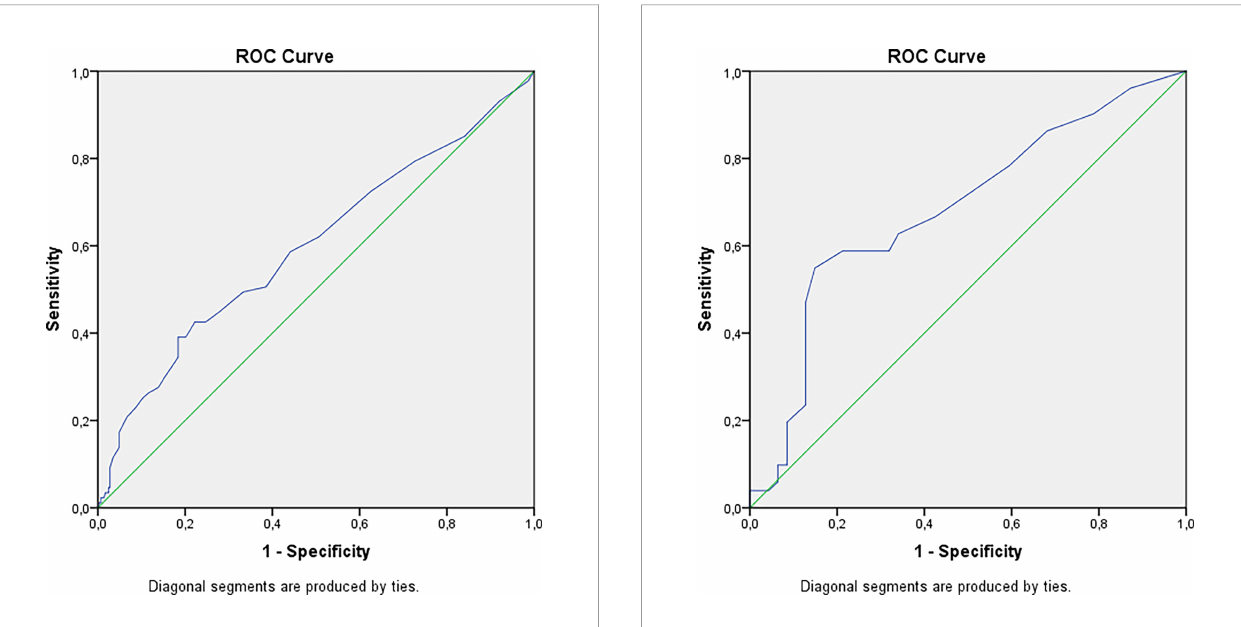
FIGURE 4 | Cut-off point for developing cataract in patients with hypoparathyroidism. AUC=0.684 (95% CI: 0.576; 0.791), р =0.002. Cut-off point – 9.5 years. Sensitivity = 55% (95% CI: 45%; 62%). Speci fi city = 85% (95% CI: 75%; 93%). PPV = 80% (95% CI: 66%; 90%). NPV = 64% (95% CI: 56%; 69%). OR = 6.96 (95% CI: 2.63; 18.43).